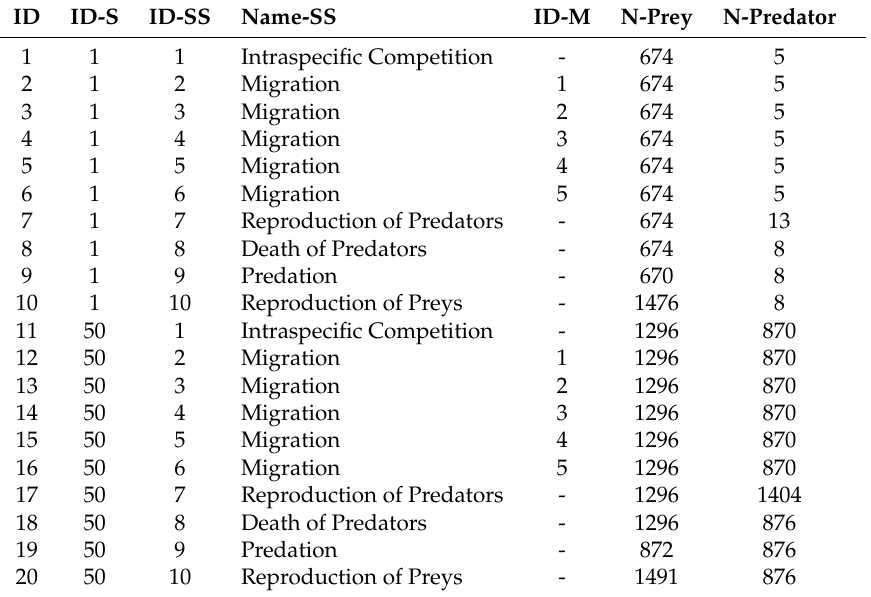
Table 11. Simulation performed using agents—Case